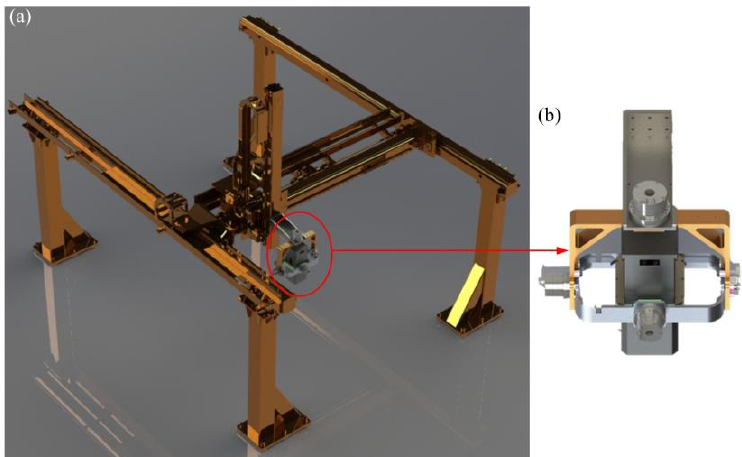
Figure 4. Six-axis-simulation-platform mechanical structure: ( a ) Three-axis-translation-table mechanical structure, ( b ) Three-axis-rotary-table mechanical structure.